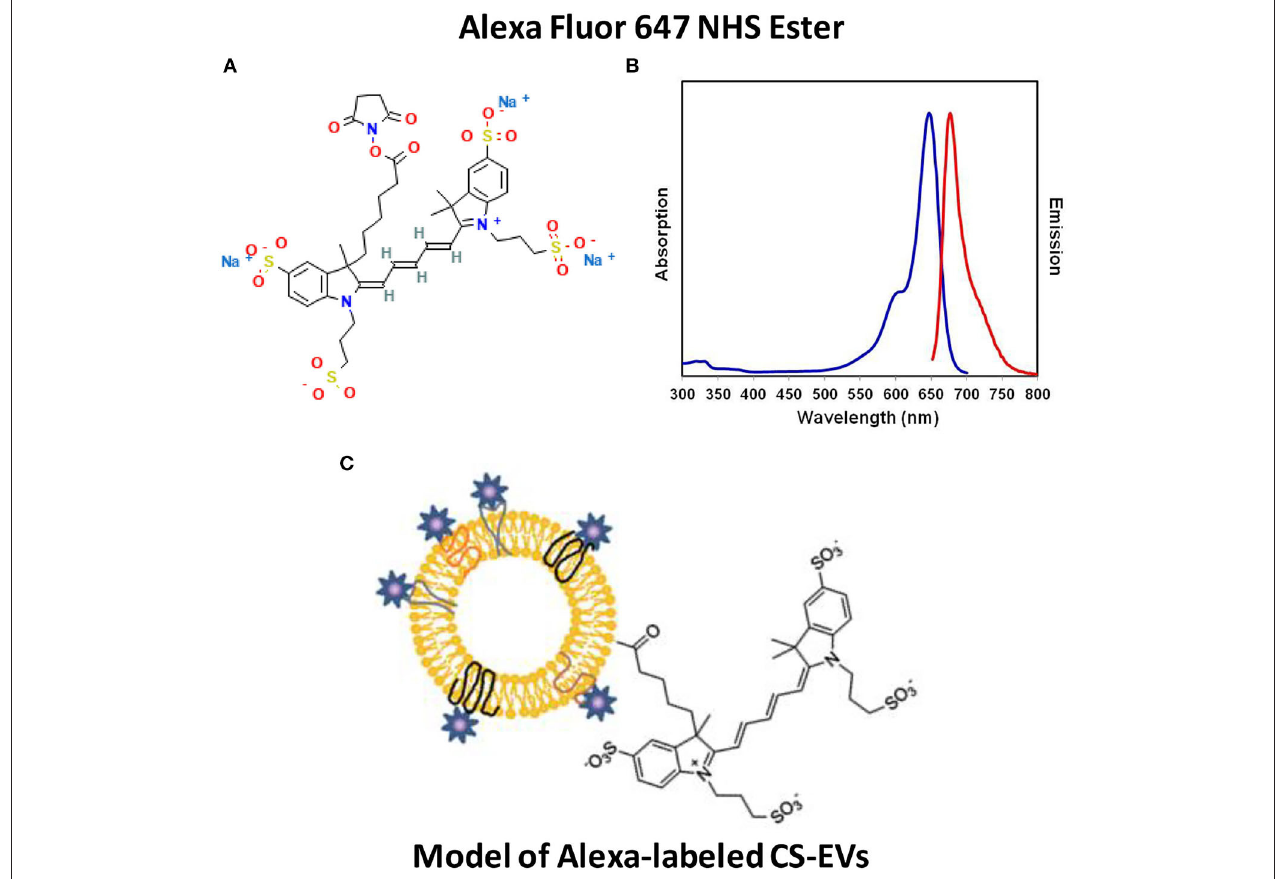
FIGURE 3 | Functionalization of CS-EVs with Alexa TM fluor 647 dye. Alexa fluor 647 NHS ester structure (A) with spectral characteristics (B) . CS-EVs can be efficiently labeled by following a simple bioconjugation protocol (C)